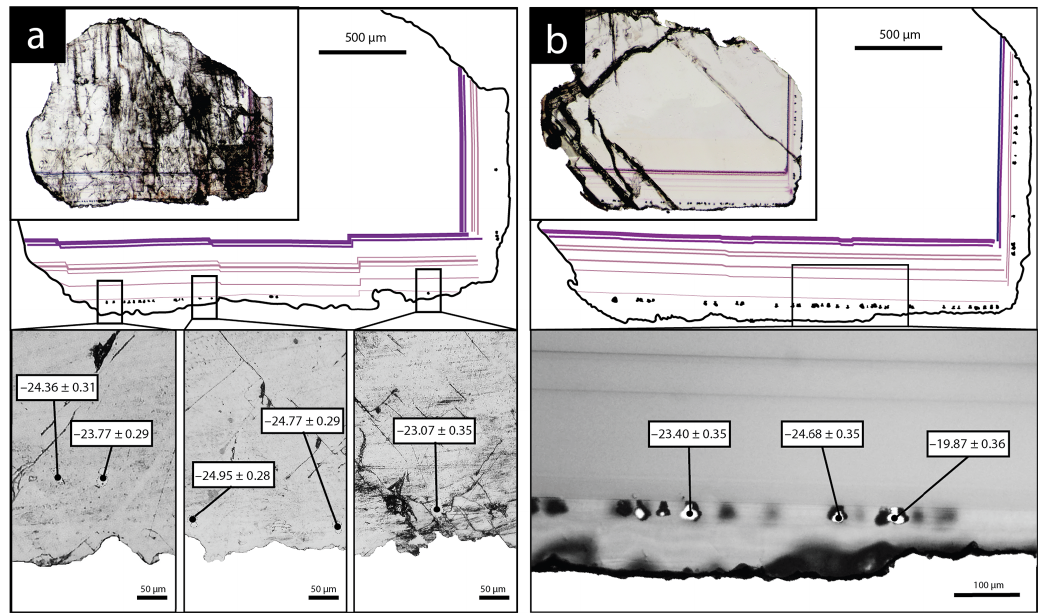
Figure 4. Location of SIMS analyses and the δ 34 S measurements (‰ V-CDT ) for (a) sample PP18S3 and (b) sample PP18S7. Micropho- tographs in the upper half are in transmitted plane-polarized light, and microphotographs at the bottom are gold metallized zoomed areas in reflected plane-polarized light.